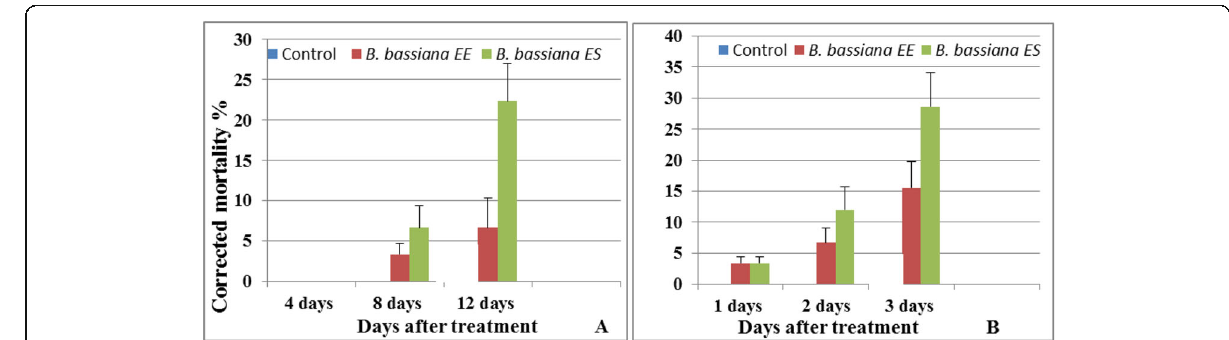
Fig. 6 Pathogenicity of Beauveria bassiana EE and Beauveria bassiana ES on squash beetle Epilachna chrysomelina larvae and adults under field conditions. a = adults, b =